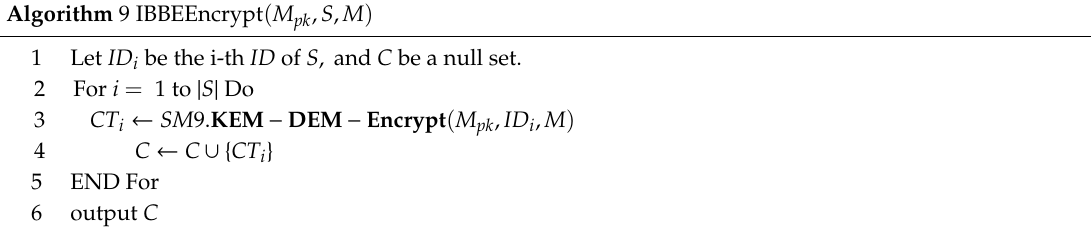
Algorithm 9 IBBEEncrypt ( M pk , S , M )